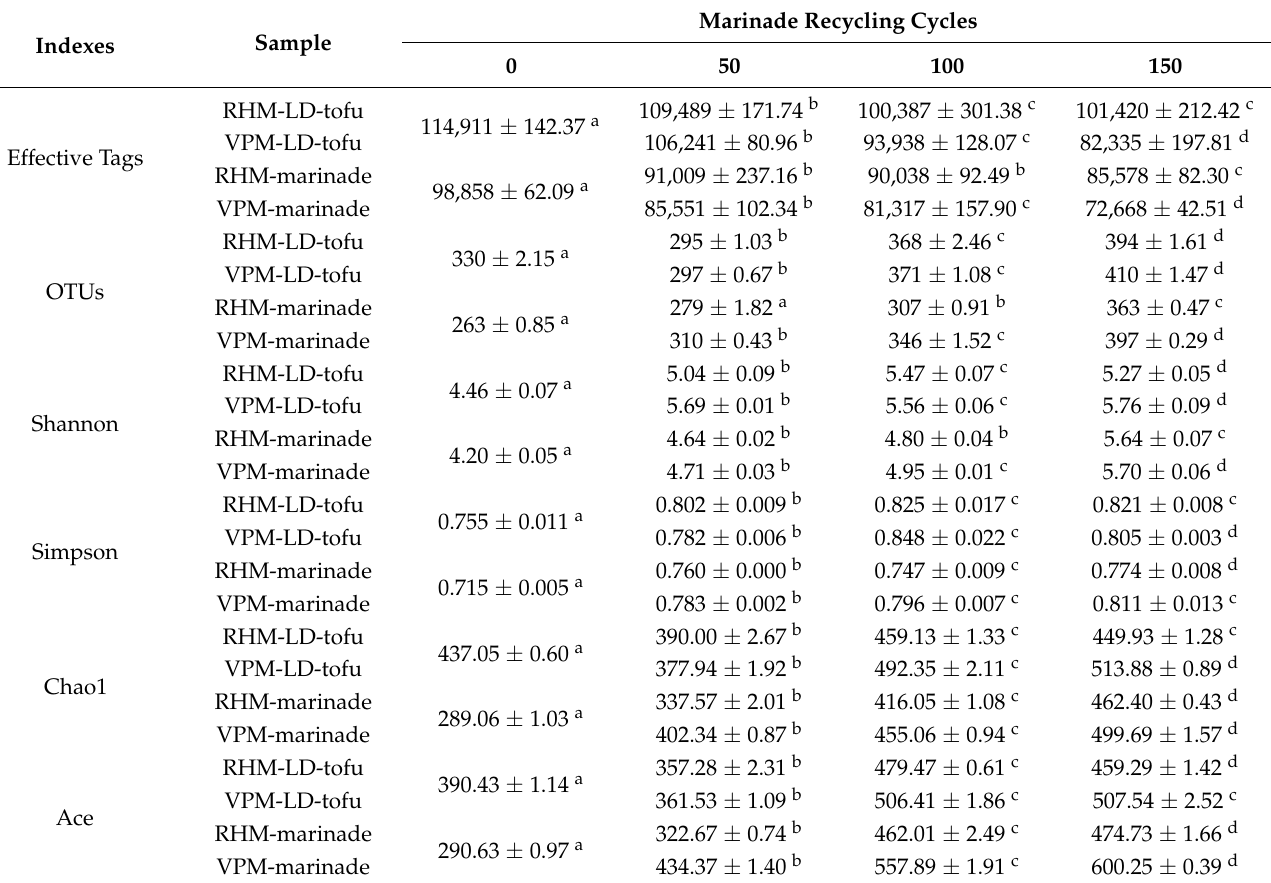
Table 2. The effects of marinating methods and marinade recycling cycles on the microbial α -diversity of LD-tofu and